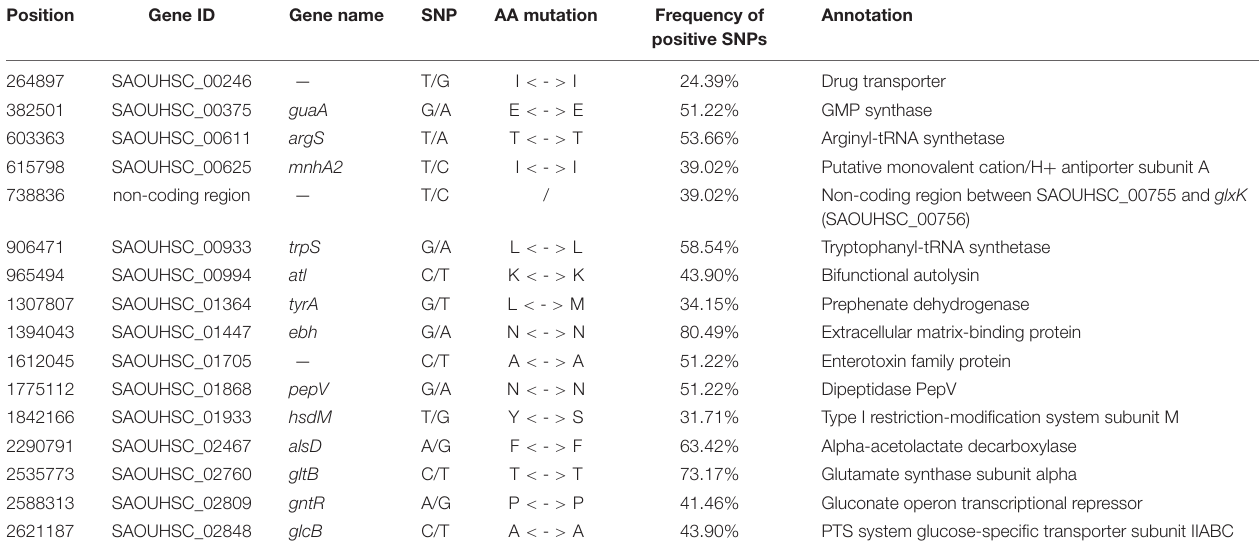
TABLE 1 | Summary of candidate genes and proteins of 16